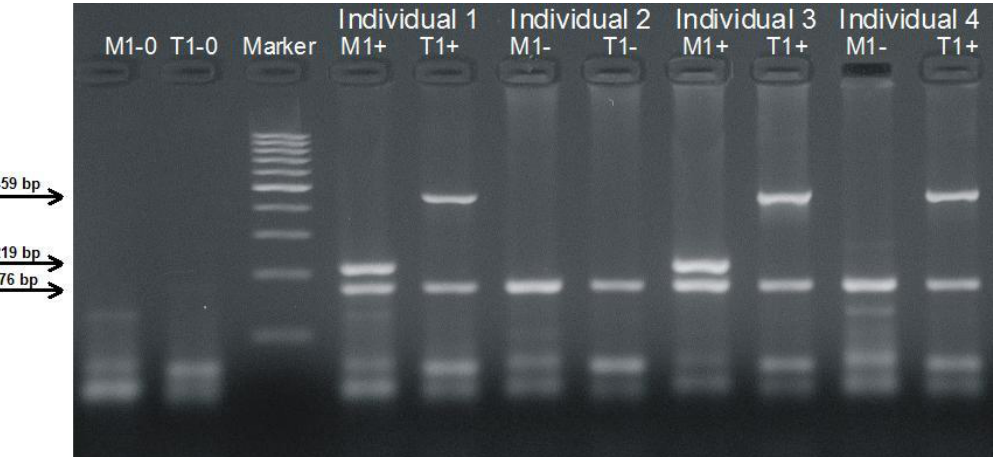
Figure 1. Genotyping of GSTM1 and GSTT1 by duplex PCRs. Non-null GSTM1 genotype individual 1 (M1+) and 3 (M1+); null GSTM1 genotype individual 2 (M1–) and 4 (M1–); non-null GSTT1 genotype individual 1 (T1+), 3 (T1+) and 4 (T1+); null GSTT1 genotype individual 2 (T1–); lines 1 and 2 (M1-0 and T1-0) are negative controls for GSTM1 and GSTT1 duplex PCRs; line 3 (marker) is a 100-bp